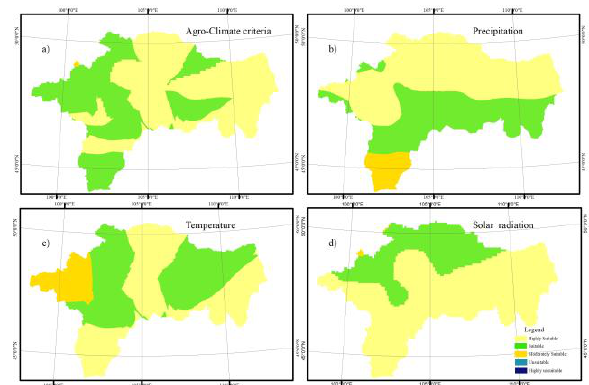
Figure 4. Generated criteria of a) agro-climate with related factors including b) precipitation, c) temperature, and d) solar radiation.